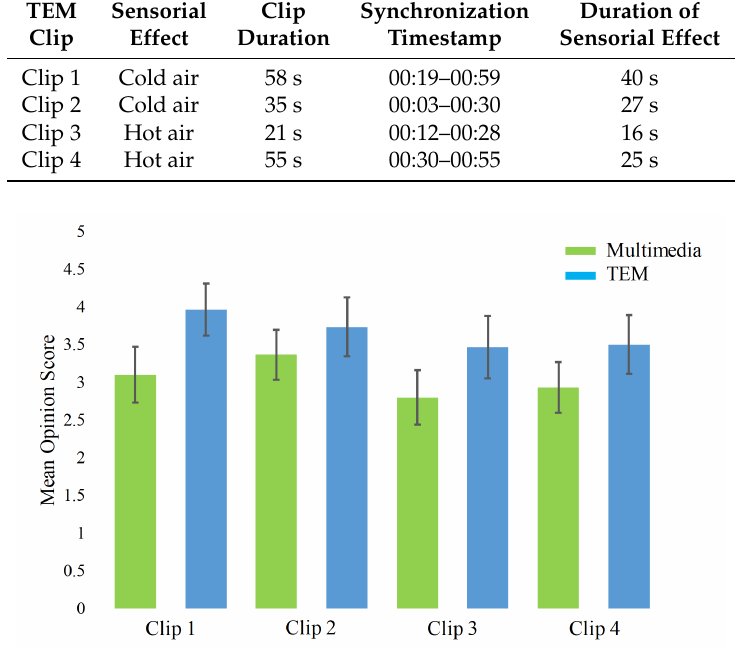
Figure 2. Confidence interval plot of MOS with 95% confidence in response to traditional multimedia and TEM